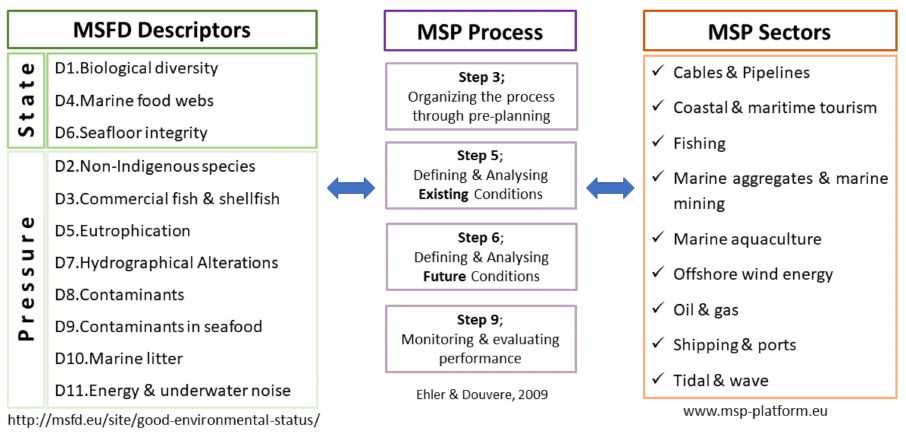
Figure 2. Relations among MSFD descriptors, MSP processes, and MSP sectors.